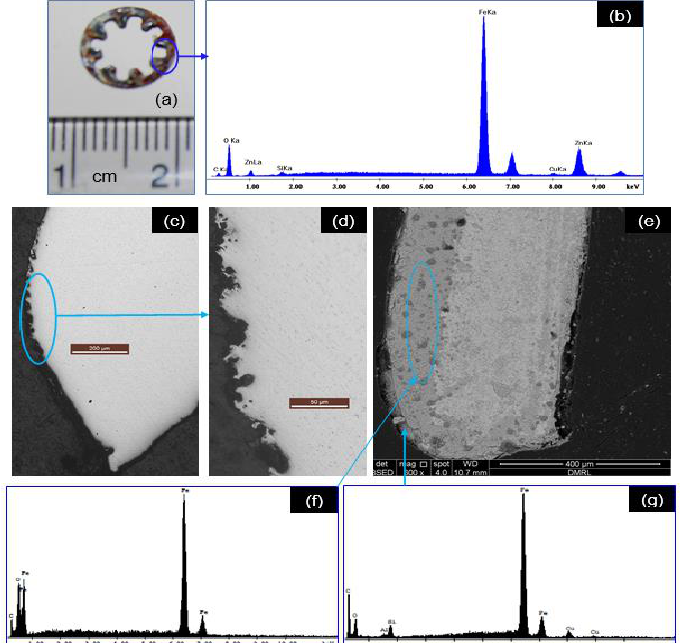
Figure 17: (a) As-received photograph of the spring washer of Figure 4a,d showing severe corrosion, (b) EDS analysis result for the corrosion debris on the as-received washer, (c,d) unetched optical micrographs along an edge showing severe pitting, (e) etched optical micrograph showing uniform as well as pitting corrosion, (f,g) EDS analysis results for the corrosion products shown in Figure